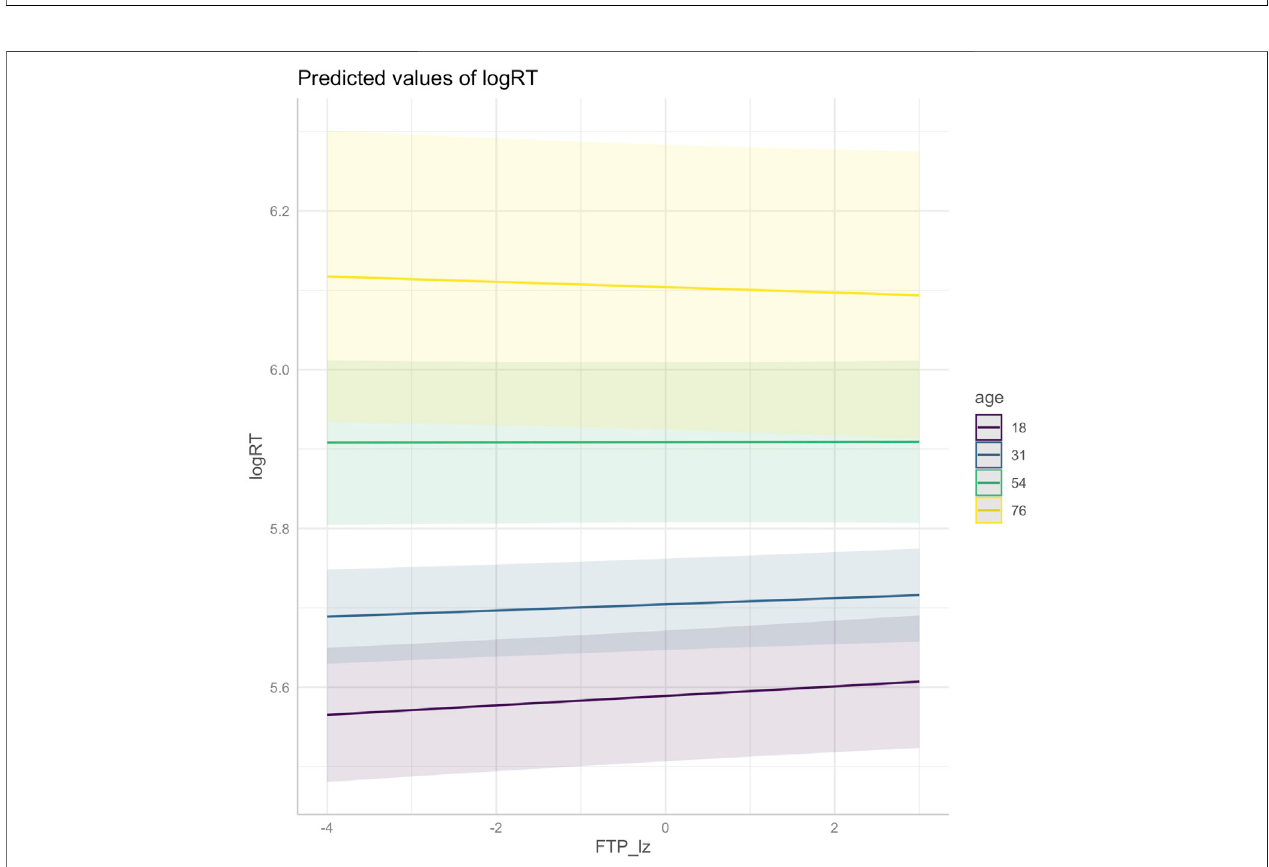
FIGURE 9 | Interaction between (log-transformed, z-scored) forward transition probability and age at sample ages (min: 18, median: 31, max: 76, and midway between median and max: 54).